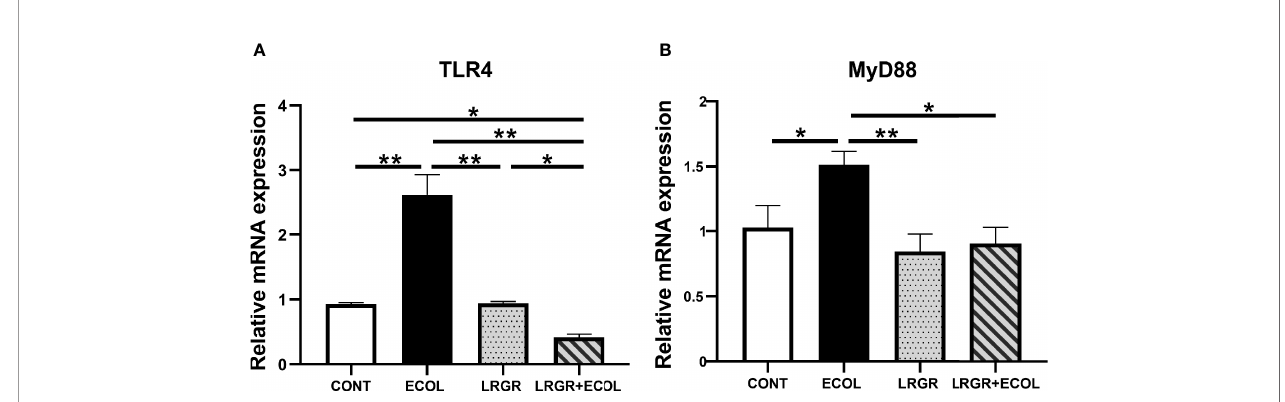
FIGURE 3 | L. rhamnosus GR-1 affects the TLR4 and MyD88 expression in E . coli -induced BEECs. (A) Expression of TLR4 mRNA and (B) MyD88 mRNA. Data are presented as the mean ± SEM of three independent experiments. * P < 0.05, ** P <